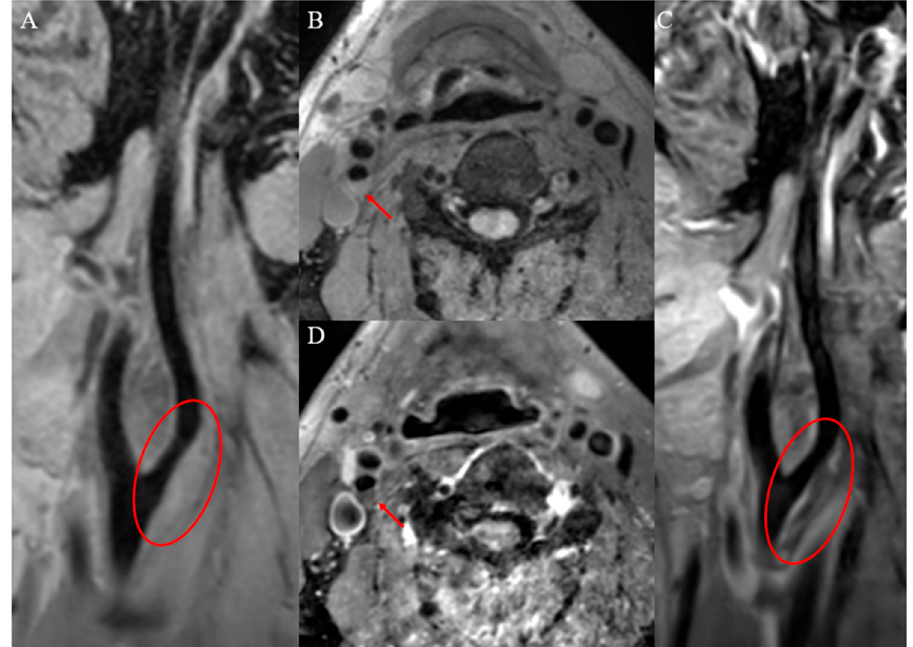
Figure 2. Definition of stable carotid plaque (intraplaque lipid and complete fibrous cap). Pre-enhanced VW-HRMRI 3D T1WI ( A , B ): homogeneous isointensity in the plaque and plaque surface was smooth. Post-enhanced VW-HRMRI 3D T1WI ( C , D ): continuous thick-linear enhancement on plaque surface.